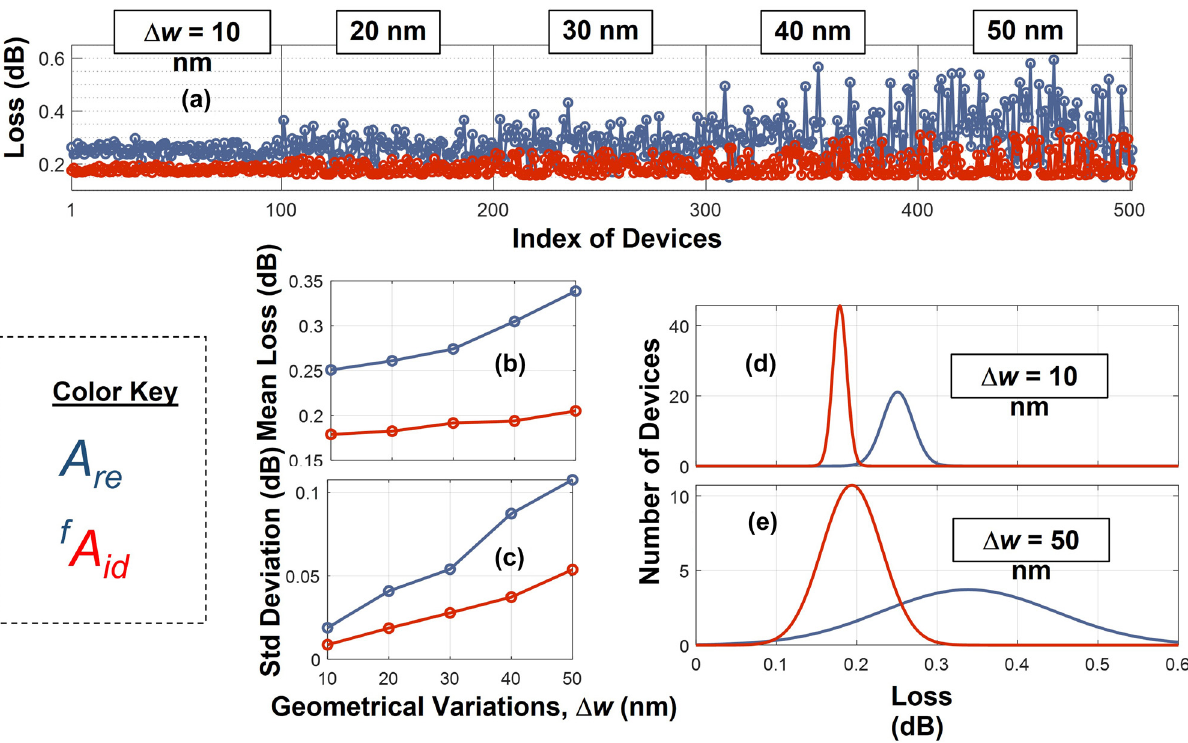
Figure 11: Robustness of devices A (blue) and A (red). (a) The FDTD losses of 500 devices with identical design but with random fluctuations of Δ w ref id in their critical parameters. (b) Mean losses and (c) standard deviation of losses as functions of Δ w . The fitted normal probability distribution functions for (d) Δ w = 10 nm and (e) Δ w = 50